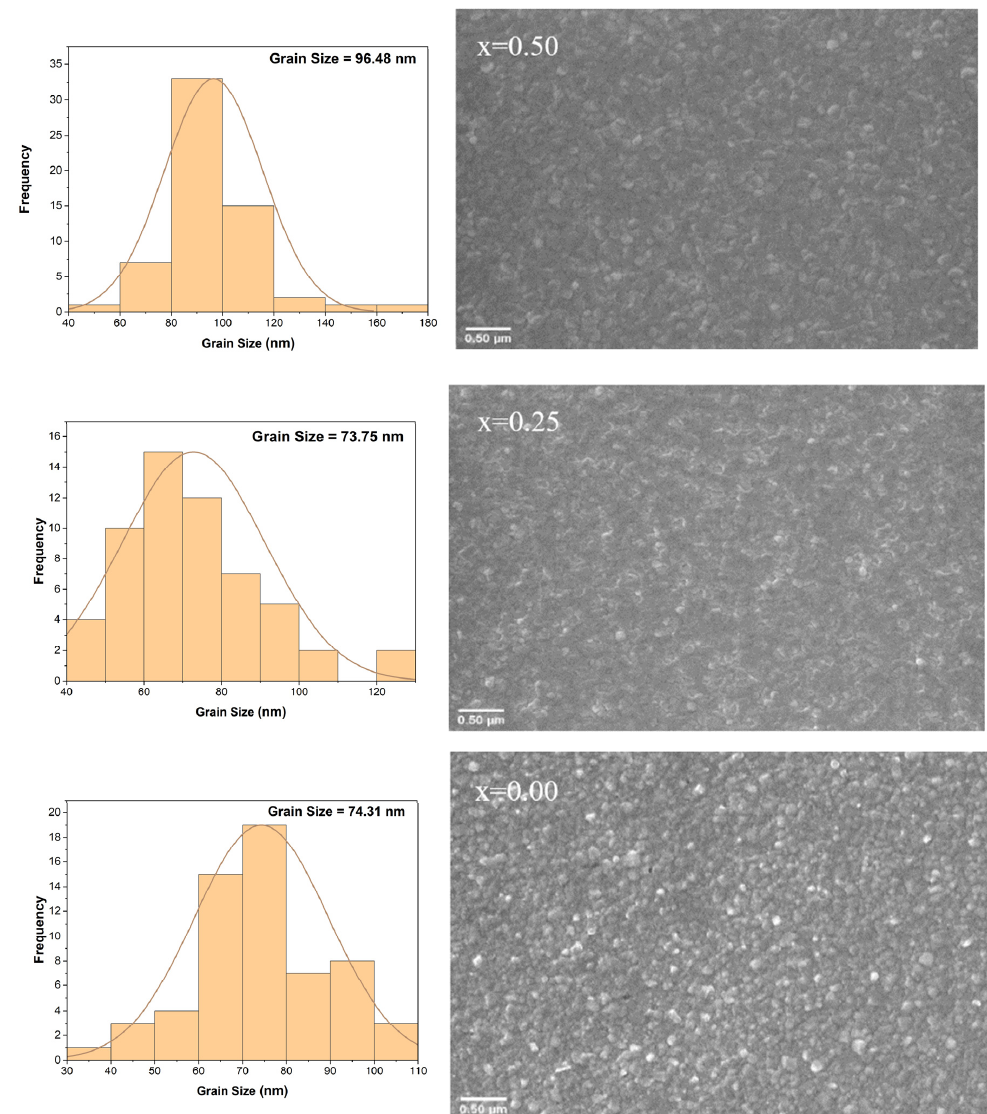
Figure 3. SEM images of the MAPb(Br x I 1 − x ) thermally evaporated perovskite films. Crystalline structures of MAPb(Br x I 1 − x ) 3 has been investigated at various values of x. Figure 4a shows the typical XRD pattern for studied samples at five values of X at room temperature. For MAPbI 3 (without Br), the planes (110), (220), and (310) belonging to the tetragonal structure [24], appear at around 2 θ ~13 ◦ , 27 ◦ , and 31 ◦ , respectively. By increasing the (Br) portion, the lattice parameters were affected, and these lines are getting shifted to appear at 2 θ ~14.21 ◦ , 29.42 ◦ , and 33.01 ◦ , respectively. Lattice parameters of the phases decrease with the increase in the total amount of bromine. For example, at x = 1.00, 0.75 the values of 2 θ were around 14.08 ◦ , 29.24 ◦ and 32.84 ◦ which correspond to (hkl) values of (100), (200), and (210) which belong to cubic phase [25–27]. In this situation, the tetragonal superlattice phase disappeared. Values of 2 θ and FWHM for each plane in five perovskites structures were tabulated in Table